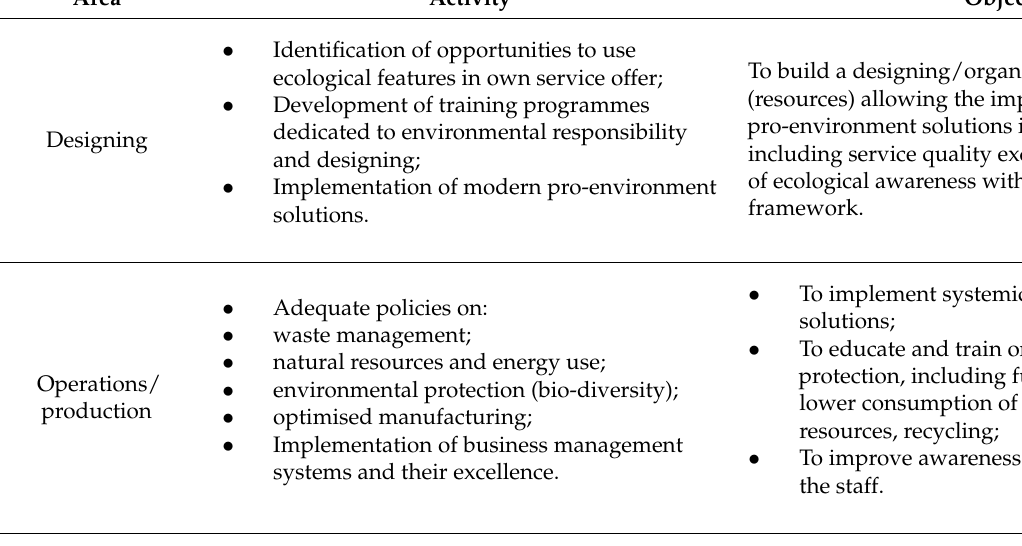
Table 1. Ecological activities in some functional areas of a heating sector operator. Source: [72–74].